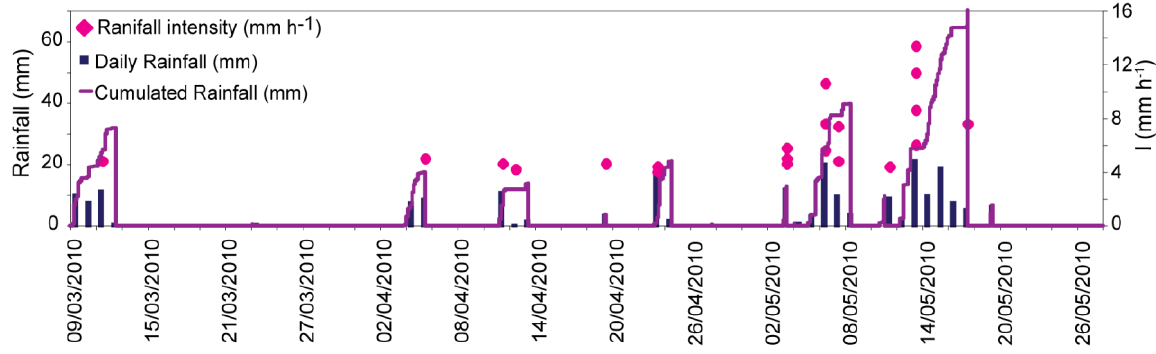
Figure 7. The pink dots represent the rainfall intensity in mm∙h −1 , the blue bars indicate the daily rainfall, and the violet line represents the cumulative rainfall. Only events that exceed 4 mm∙h −1 are